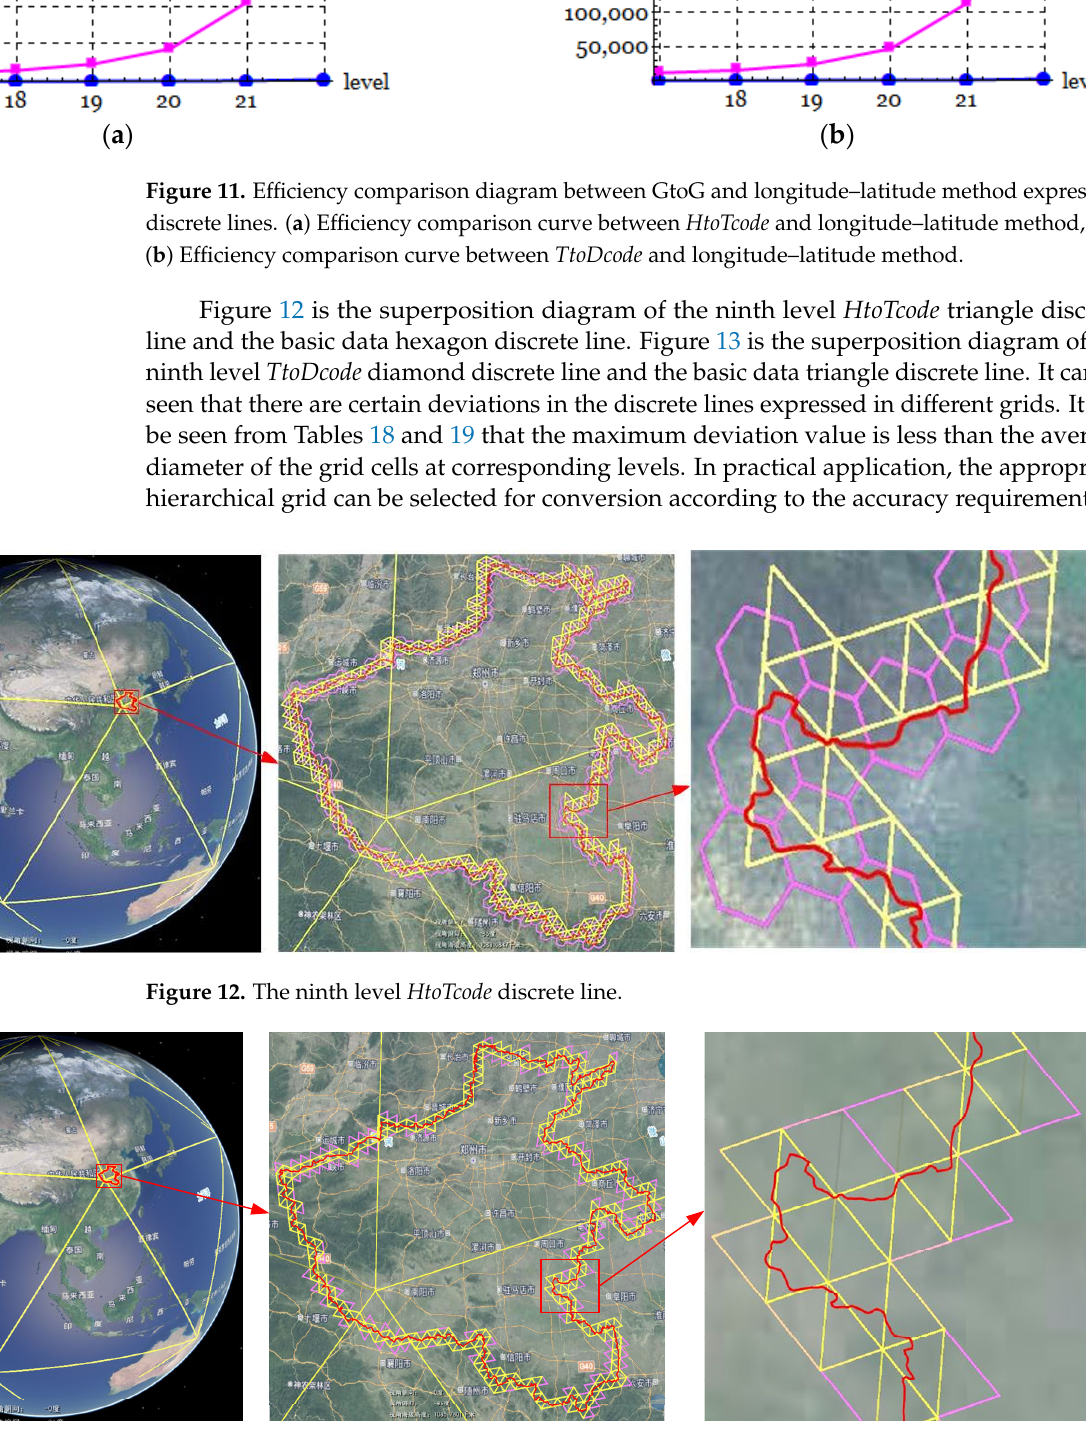
Figure 13. The ninth level TtoDcode discrete line.